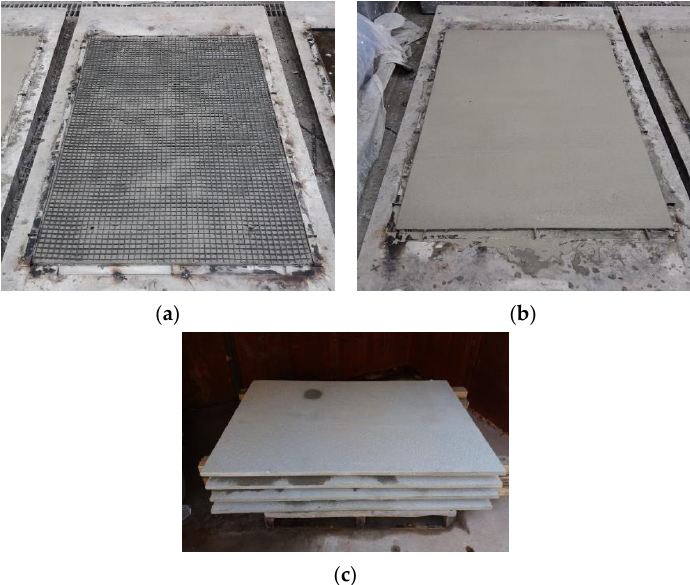
Figure 2. Fabrication process of precast TRC panel: ( a ) 1st mortar layer and textile grid placement; ( b ) 2nd mortar layer placement; ( c ) cured TRC panels.